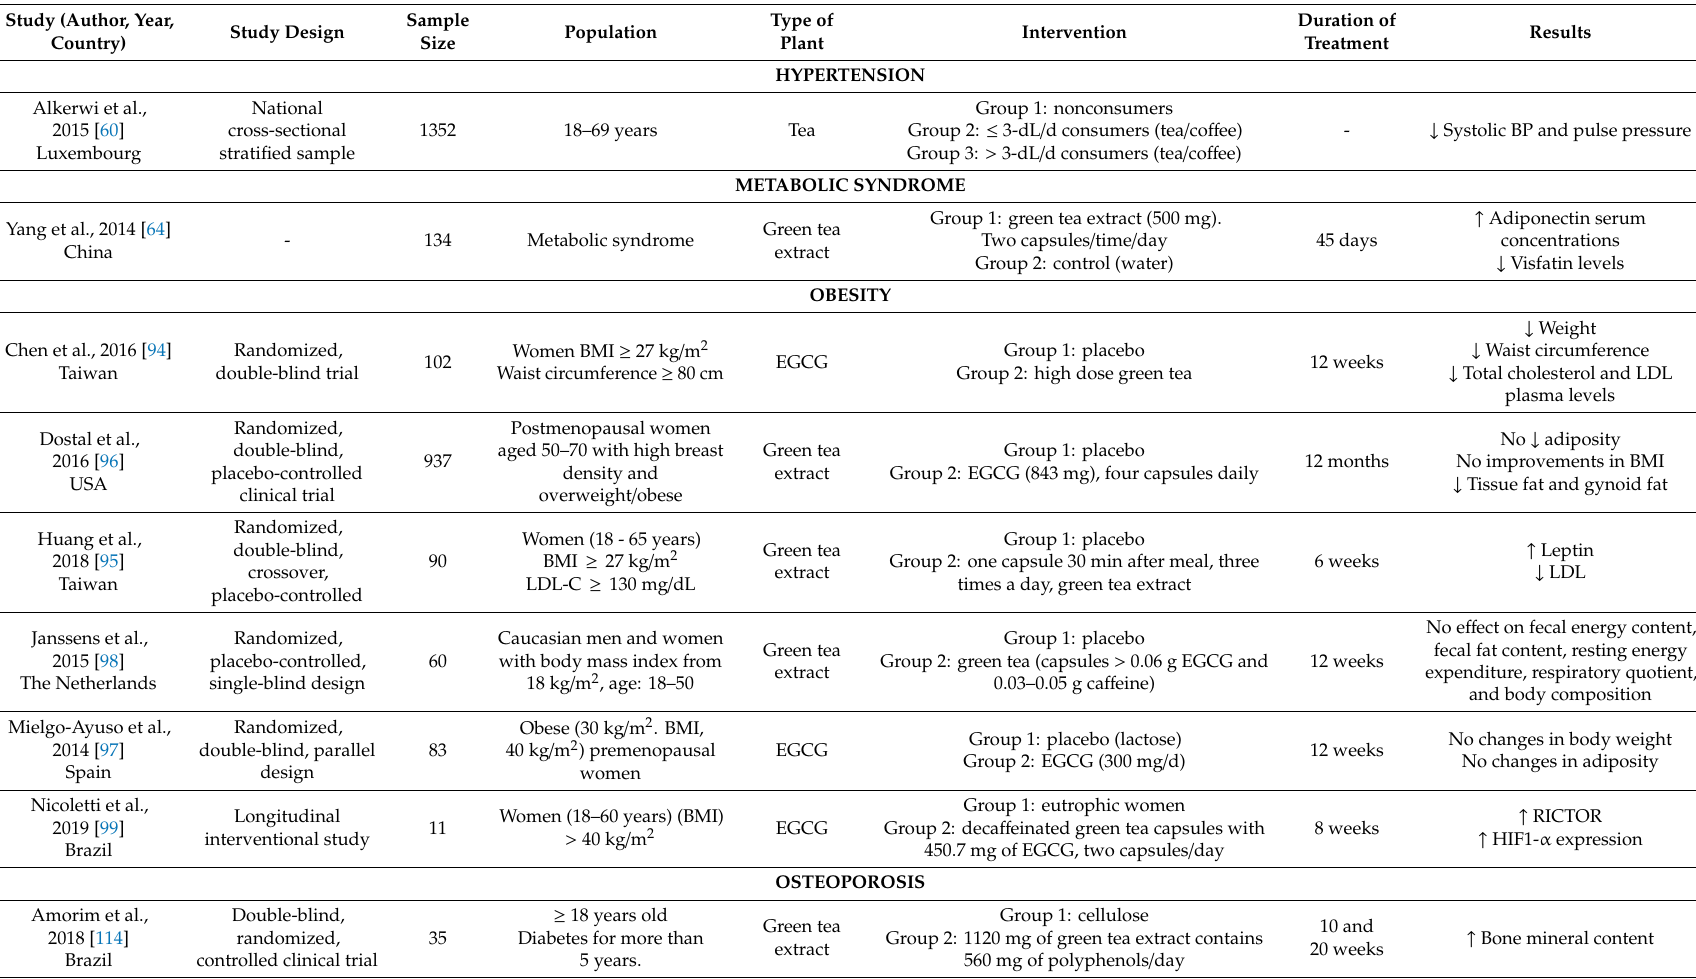
Group 1: eutrophic women Group 2: deca ff einated green tea capsules